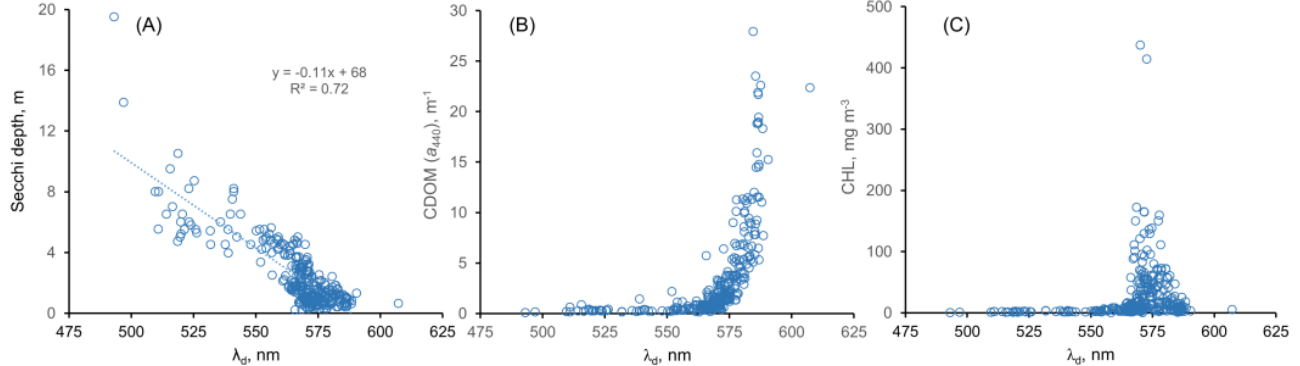
12 of 18 Figure 7. Calculated λ d values using the Wang method versus λ d,hyp after α correction for the three sensors. The blue circles represent data points where hue angle was corrected; the orange (×) data points represent values where corrections were not applied. The r egressions of the corrected Wang λ d values versus the vdWW λ d values for the three sensors (S-2, S-3, and L8; plots not shown) yielded high R 2 values (0.98, 0.97, and 0.99, respectively), with the slopes of the relationships being close to unity (1.07, 1.02, and 0.99, respectively) and with low error rates (MADs of 2.37, 2.63, and 1.02 nm and MAPDs of 0.42, 1.37, and 0.48%, respectively); the vdWW results were the reference (assumed to be correct) values in each case. The bias values were small (0.8, 2.0, and 0.1 nm, respectively; L8 was especially low). Consequently, both methods worked well for water bodies for which the calculated α values could be corrected. For the vdWW method, this covered nearly the entire range of water bodies in the MNWI dataset, but α could not be corrected for lakes with moderate chlorophyll (>~10 mg m −3 ) or CDOM (>~2 a 440 (m −1 ); relatively low α and high λ d ) levels for the Wang method, and the method, thus, worked well only for ~55% of the water bodies in the MNWI dataset. 4.3. Dominant Wavelength and Water Quality Relationships The v alues of λ d,hyp were related to four water quality parameters (SD, CDOM, CHL, and FUI; Figures 8 and 9). As Figure 8A shows, the SD tended to decrease in a fairly linear fashion as the λ d,hyp increased. The inverse of SD is linearly related to light attenuation coefficien ts, but a plot of 1/SD versus λ d (not shown) did not yield an obvious relationship. The CDOM values increased very non- linearly as λ d,hyp increased, starting near 560 nm, with most of the increase occurring in a narrow range above λ d = 575 nm (Figure 8B). In contrast, the CHL values peaked around λ d,hyp = ~575 nm Figure 8C). A challenging aspect of the relationship between λ